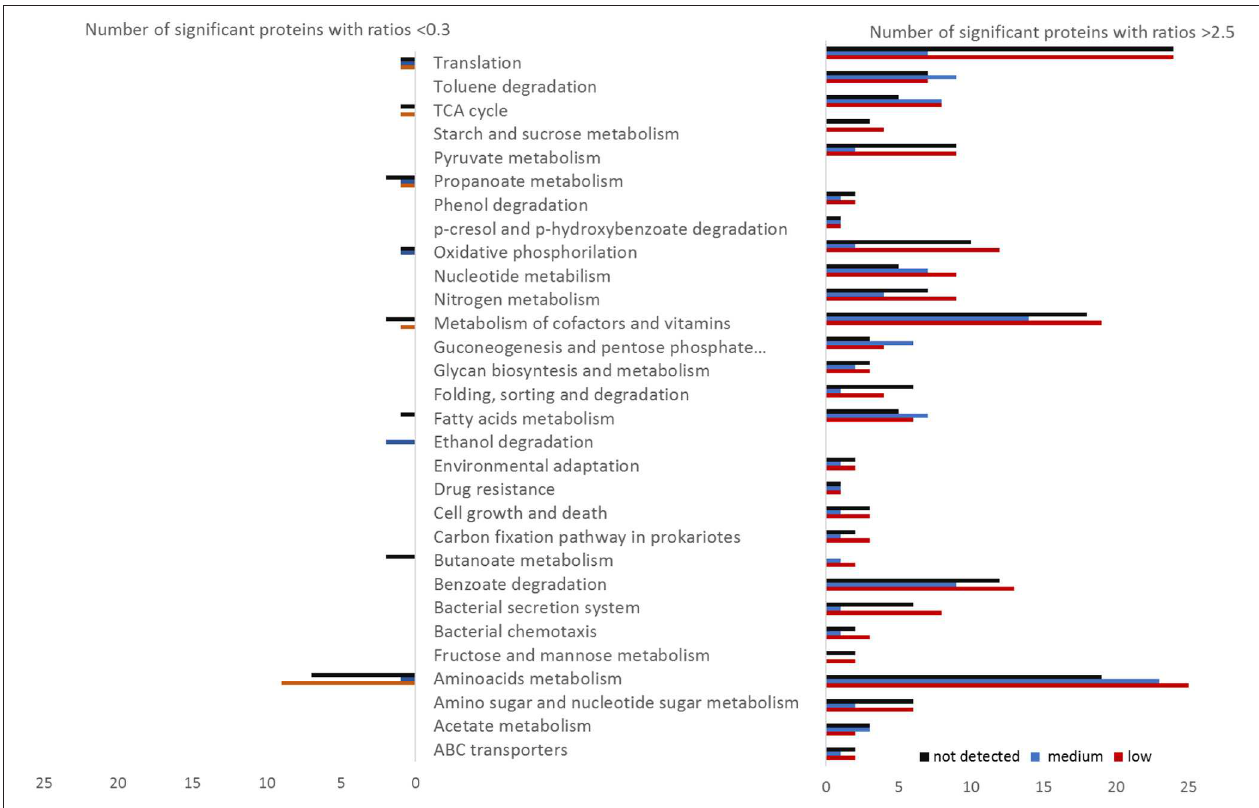
FIGURE 3 | Number of Geobacter proteins with significantly different abundances (ratio above 2.5 or below 0.3) at low (red), medium (blue), or not detected (black) benzoate concentrations relative to the reference condition of high benzoate concentration in the column 1. The proteins were sorted by functional categories according to